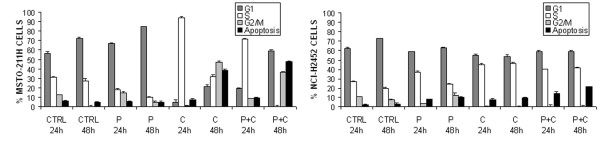
Effects of piroxicam and/or CDDP on cell cycle regulation in MSTO (left panel) and NCI cells (right panel). Cells were treated with piroxicam and/or CDDP for 24 and 48 hours and analyzed to determine cell cycle phase distribution. All the experiments were performed at least 3 times. Media ± Standard deviation of experiments is expressed as percentage of total cells. CTRL = control; P = piroxicam; C = CDDP.